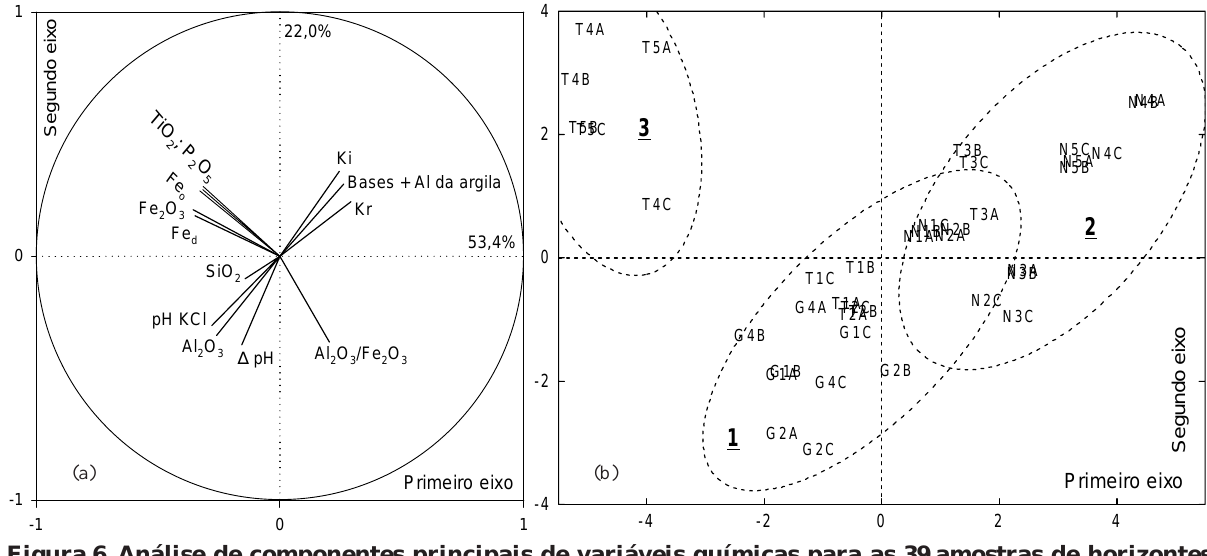
Figura 6. Análise de componentes principais de variáveis químicas para as 39 amostras de horizontes subsuperficiais avaliadas. (a) Círculo de autovetores das variáveis (Fed = Fe extraído pelo ditionito- citrate-bicarbonato; Feo = Fe extraído pelo oxalato ácido de amônio; Fe respectivos óxidos extraídos pelo ataque sulfúrico); (b) Plano de elipses e dispersão de pontos dos grupos de perfis de solos. Pontos como códigos de cada perfil. Elipses: 1 = solos de textura argilosa a muito argilosa, hipo a mesoférricos; 2 = solos de textura média a arenosa, hipoférricos; 3 = solos de textura argilosa a muito argilosa,